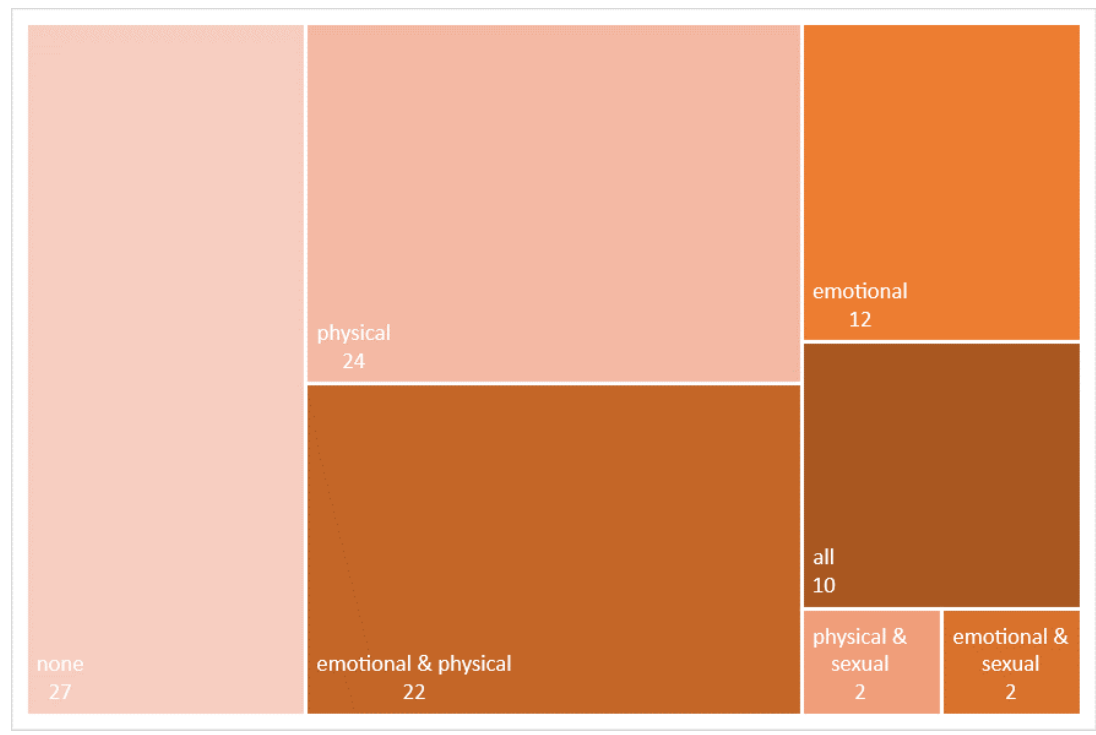
Figure 1. Percentages of each profile according to the type of violent behaviour they reported they had exerted.